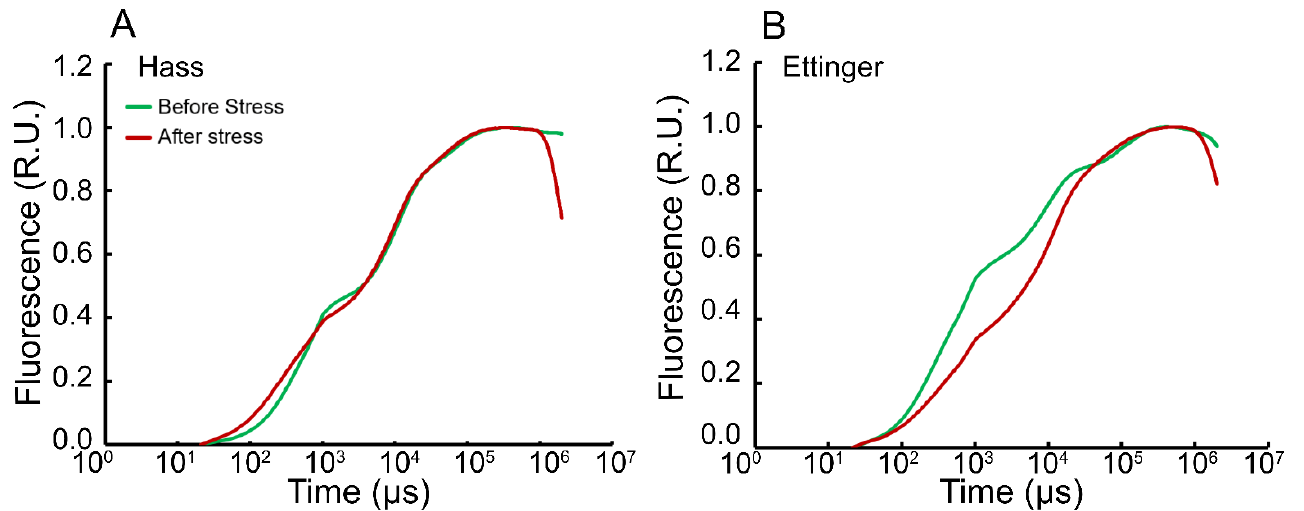
Figure 3. Double normalized fluorescence transient profiles for two cultivars of avocado ( P. Americana Mill) before and after frost stress. Panels ( A , B ) represent data for cultivars Hass and Ettinger, respectively. Each panel includes two curves which are average of six biological repeats (N = 6). The colors green and dark red represent information gathered right before (‘Before’) and right after (‘After’) cold stress inflicted on the samples.